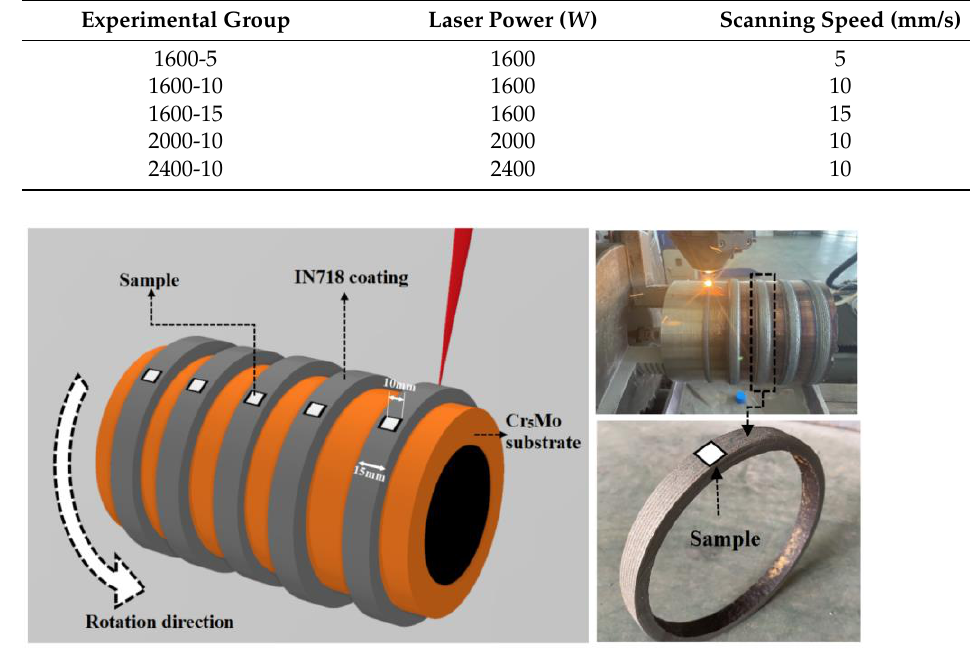
Figure 2. Preparation of laser cladding samples with different parameters on Cr5Mo.